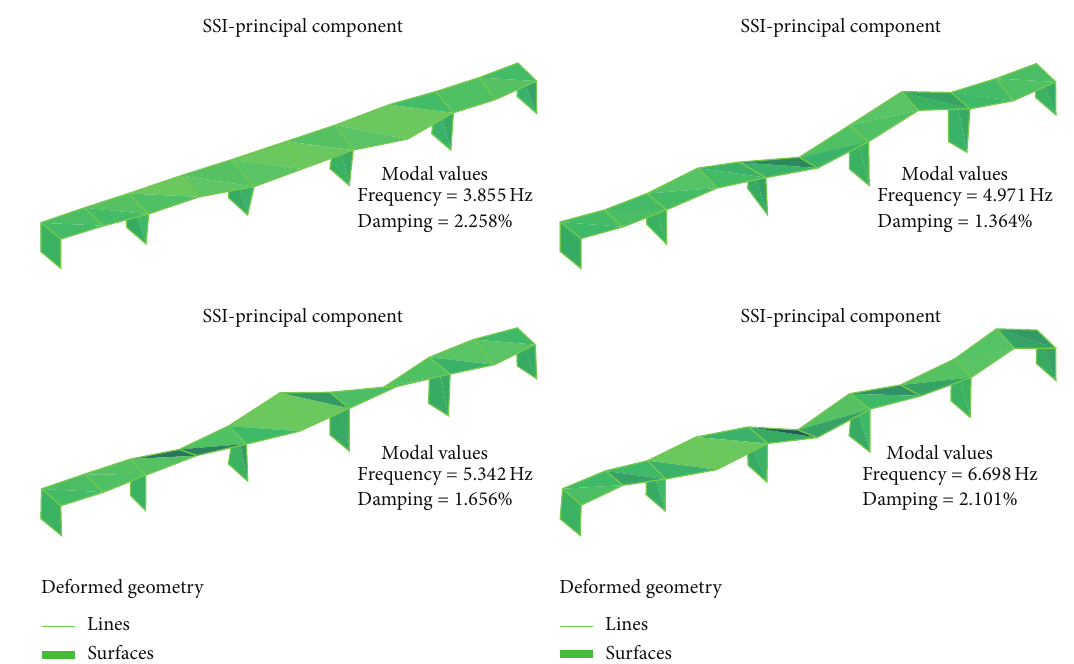
Figure 12: Experimental modal parameters attained from the test setup.